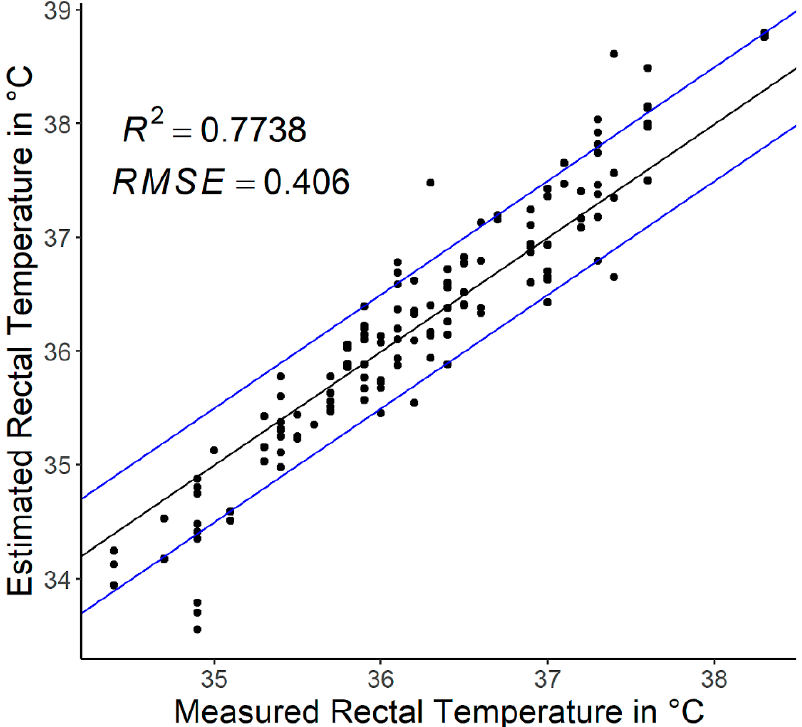
Figure 7. Results of the best multiple linear model (8 features) on all data. The blue lines highlight a deviation of ± 0.5°C from the measured rectal temperature.